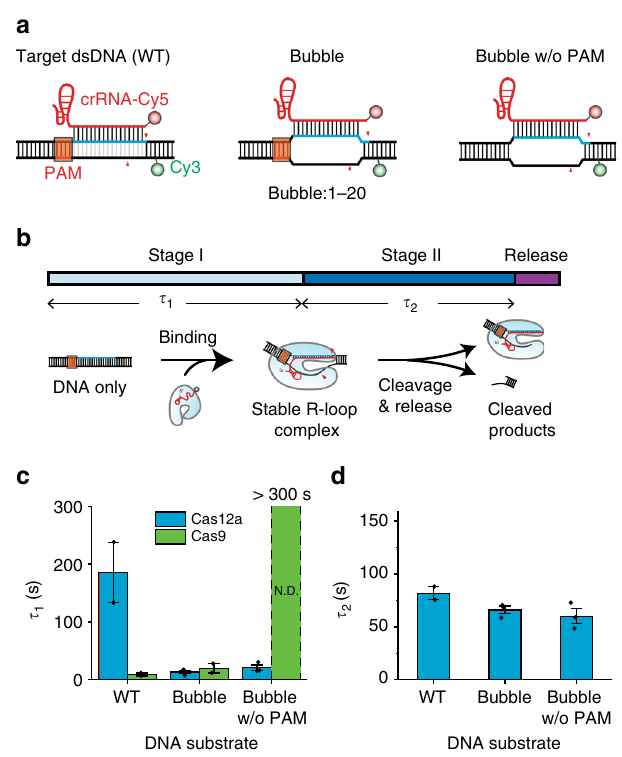
Fig. 5 The PAM serves a limited role for AsCas12a function. a Diagram of DNA templates. Target dsDNA (WT) (left) contains a PAM and a proper protospacer. Bubble DNA (middle) has a PAM and a bubble structure (mismatches between the target and non-target strands) in the protospacer. Bubble w/o PAM (right) is the same as Bubble DNA except that it lacks a PAM sequence. Cy3 and biotin modi fi cations are identical for all three DNA templates. b Schematic diagram of the single-molecule FRET experiment. c , d Target binding time τ 1 ( c ) and cleavage time τ 2 ( d ) of the AsCas12a – crRNA complex for the three different DNA templates. At least 171 time traces are analyzed to obtain τ 1 and τ 2 from two independent experiments (for Cas12a: 214 for WT, 171 for Bubble, 271 for Bubble w/o PAM, for Cas9: 404 for WT, 410 for Bubble, 396 for Bubble w/o PAM) (mean ± s.e.m.). All values in this fi gure are measured with a same concentration; 10 nM of protein (AsCas12a or SpCas9) and 20 nM